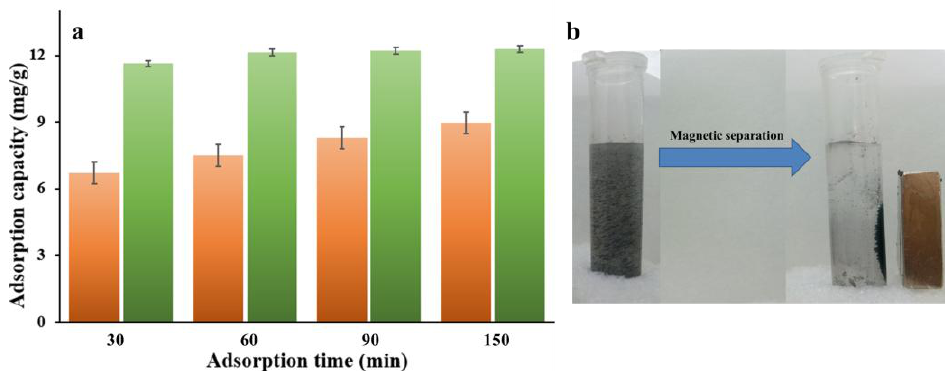
Figure 7. ( a ) Plots of adsorption capacity vs adsorption time of MNPC and MC in the NOR aqueous solutions at concentrations of 10 mg L −1 ; and （ b ） the photo of MNPC separated under an external magnetic field.